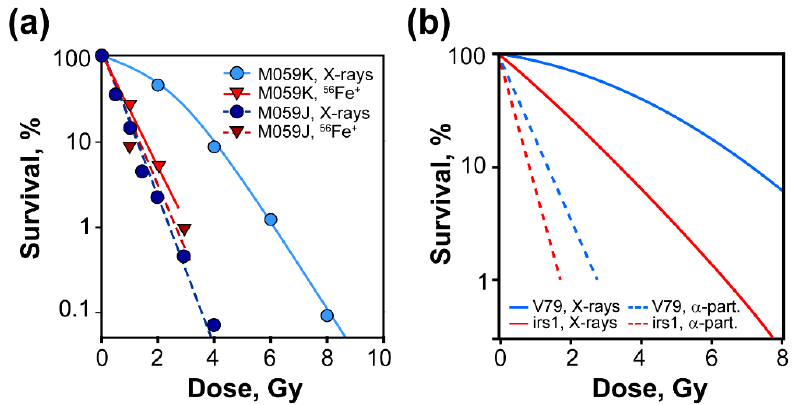
Figure 3. ( a ) Representative survival experiments with DNA-PKcs-proficient (M059K) and DNA-PKcs-deficient (M059J) cells exposed to low LET (x-rays) and high LET (56Fe+ ions, LET = 151